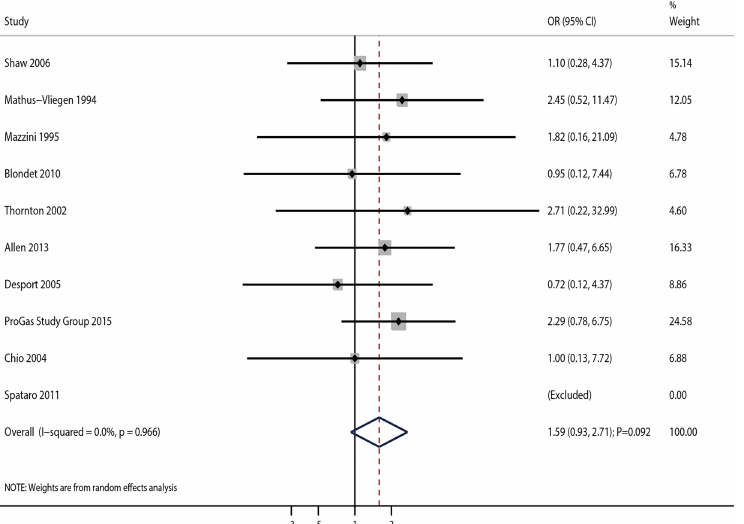
Fig 2. Association of PEG use with 30-day survival